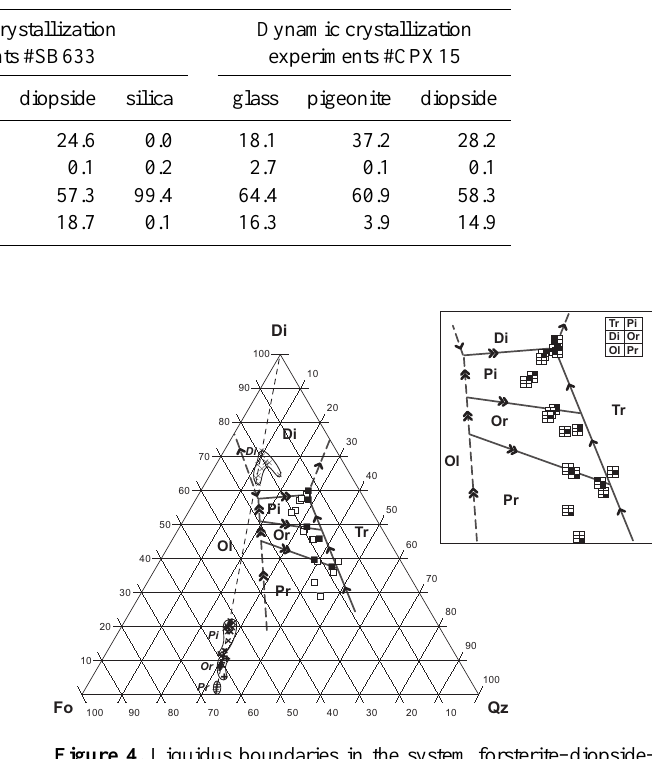
Fig. 4. Liquidus boundaries in the system forsterite-diopside-anorthite-silica. Represented join is Fo 95 An 05 -Di 95 An 05 -SiO2 95 An 05 : this plane is parallel to the pseudo-ternary Fo-Di-SiO2 and contains 5% An. Squares are liquid compositions saturated with two crystalline phases (white squares) or three crystalline phases (black squares). Analysis of pyroxene crystals are also drawn. Single arrows indicate cotectic curves; double arrows indicate reaction curves.